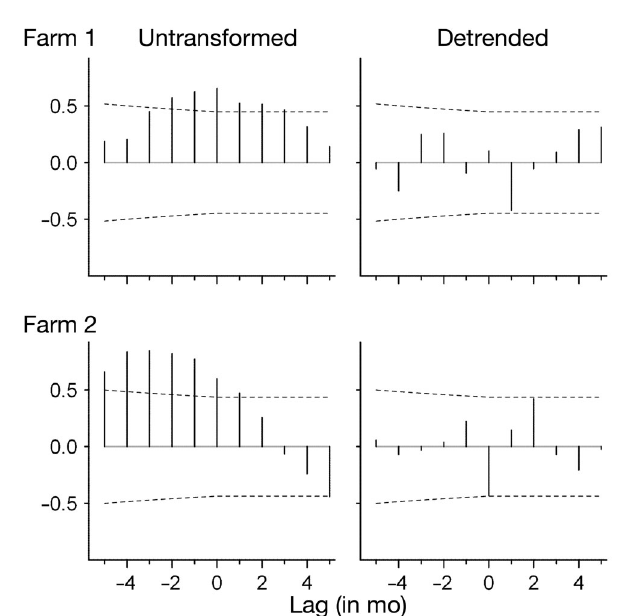
Fig. 5. Cross-correlations (thick vertical lines) between sea lice (all stages) abundance on the sentinel fish and on the fish from 2 farms using both untransformed and de-trended data. The cross-correlation at lag zero is the correlation between counts in the sentinel cages and the farms in the same month; the cross-correlation at a lag of 1 mo is the correlation be- tween counts in the sentinel cages and the farms 1 mo be- fore; and so on. Correlations outside the dashed reference lines are significant at the pointwise 5%